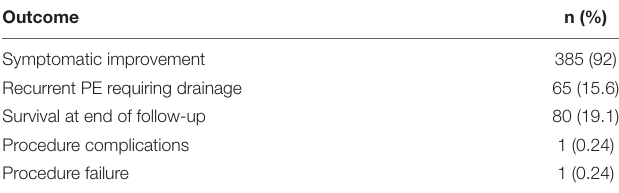
TABLE 2 | Outcomes of patients with index pericardiocentesis.